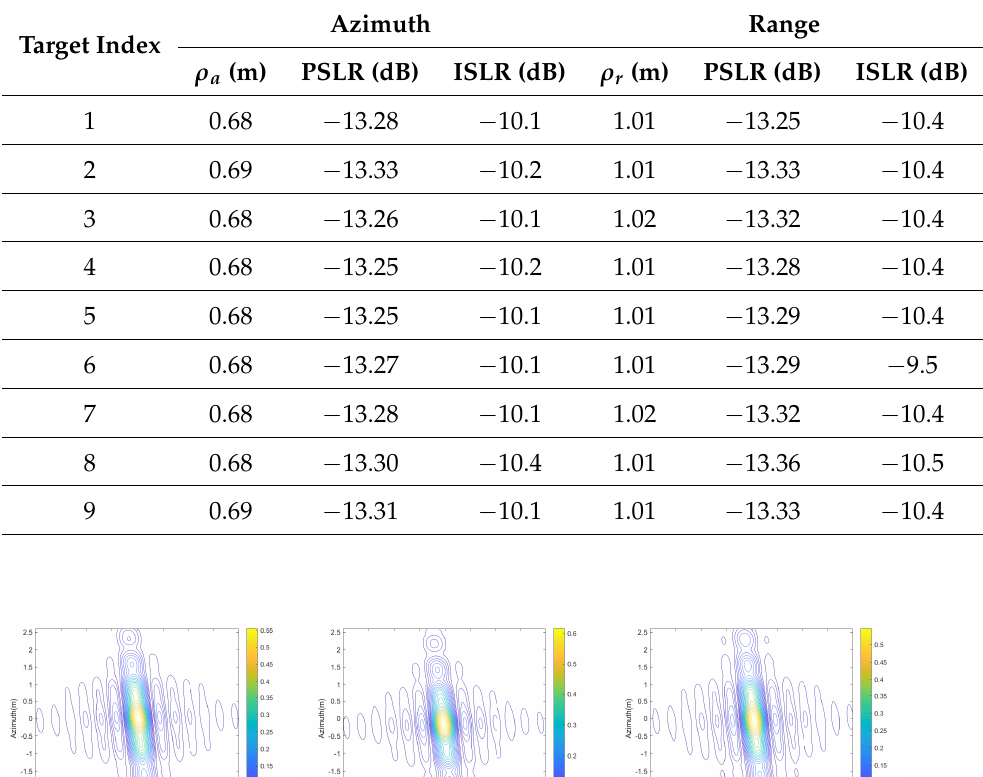
Table 2. Measured imaging metrics of the nine point targets by the proposed method based on BiCoT-ESRM.